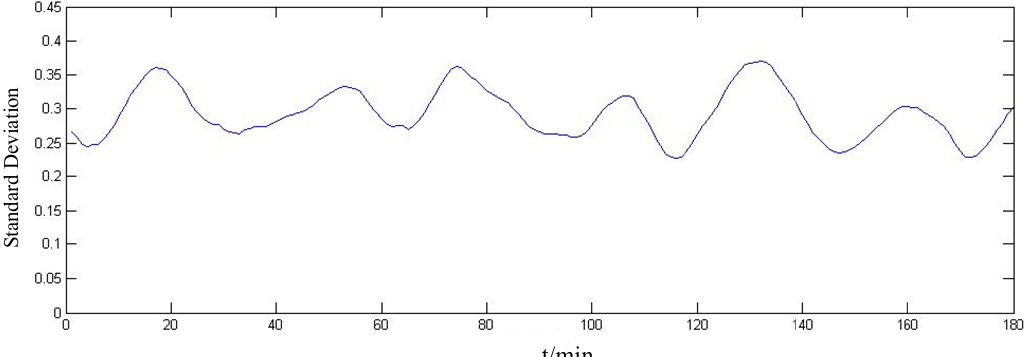
Figure 12. Variation of VES diversity of electric water heaters (after optimized).